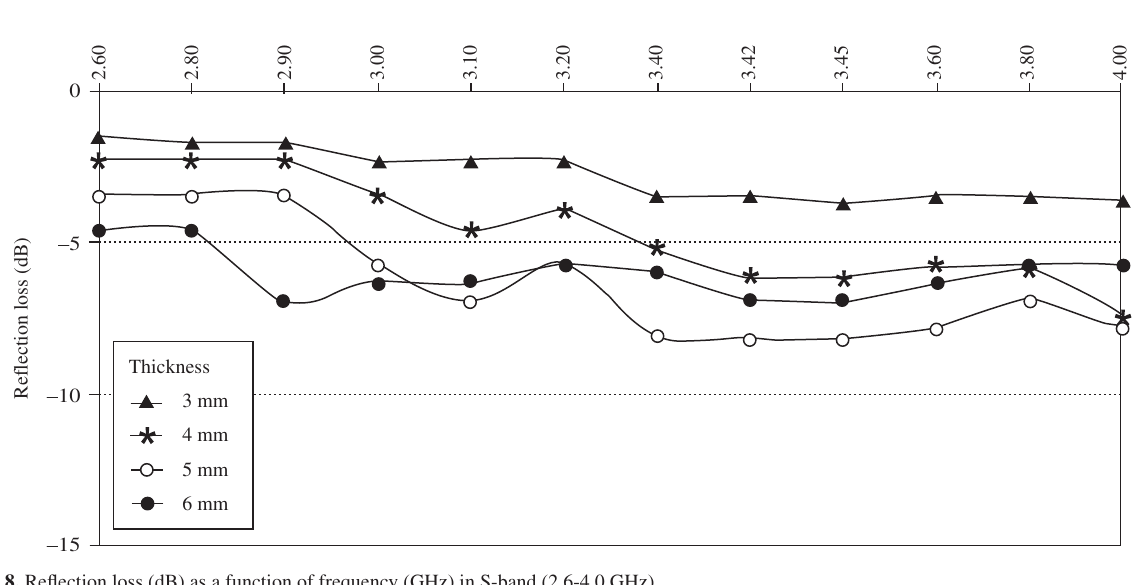
Figure 8. Reflection loss (dB) as a function of frequency (GHz) in S-band (2.6-4.0 GHz).